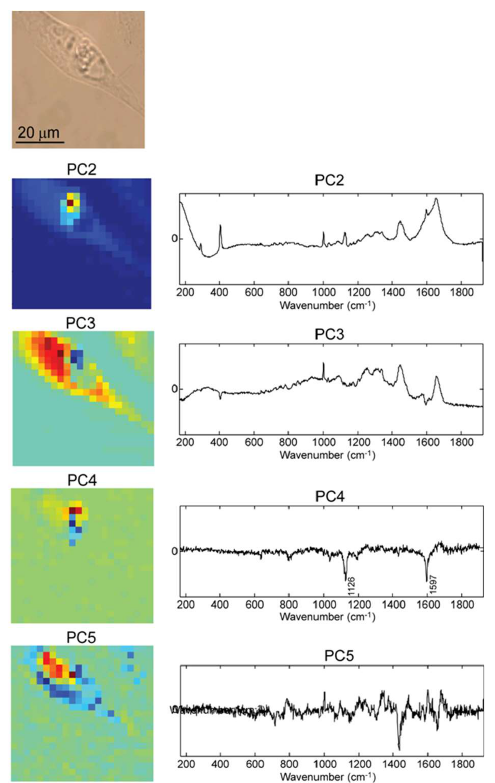
Figure 5. From top to bottom: Optical microscopy image of a D407 cell transfected with empty PEM capsules; followed by the Raman score plot (map) and the corresponding loading plot of relevant principal component PC2, PC3, PC4, and